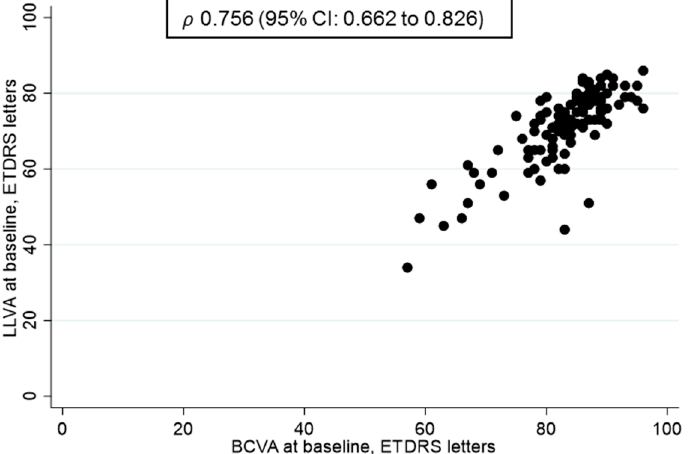
Figure 2. The relation between best corrected visual acuity (BCVA) and low luminance deficit (LLVA) in treatment naïve proliferative diabetic retinopathy (PDR) eyes. Spearman’s Correlation was 0.756 (95% CI: 0.662 to 0.826).